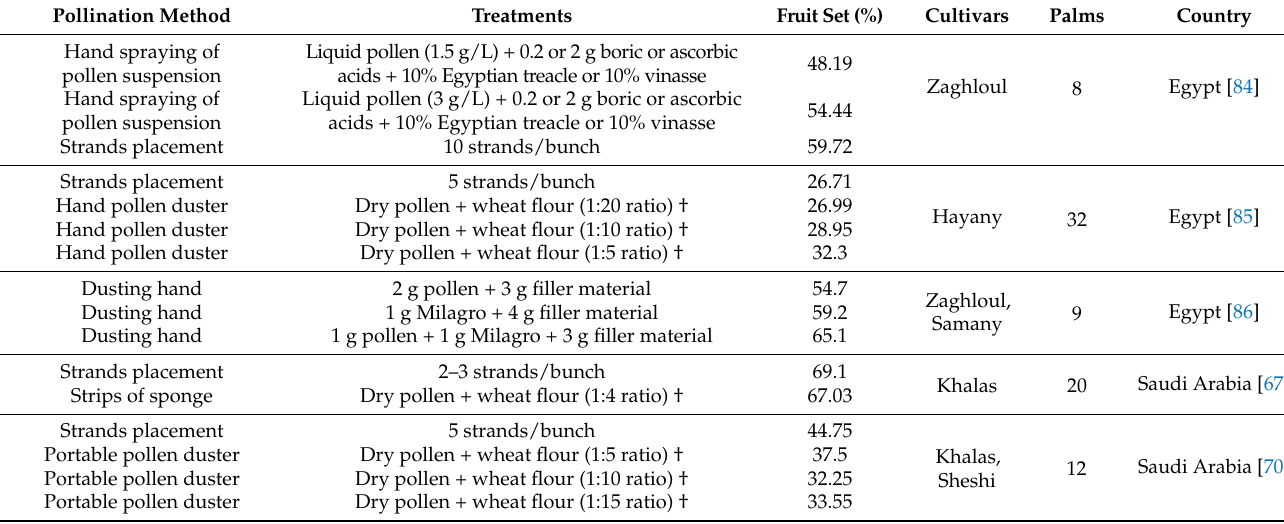
Table 2. Efficiency comparison of the different pollination methods on various date palm